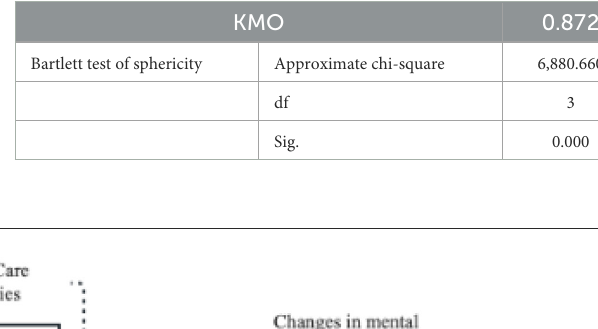
TABLE 2 Validity test of community spiritual comfort service.